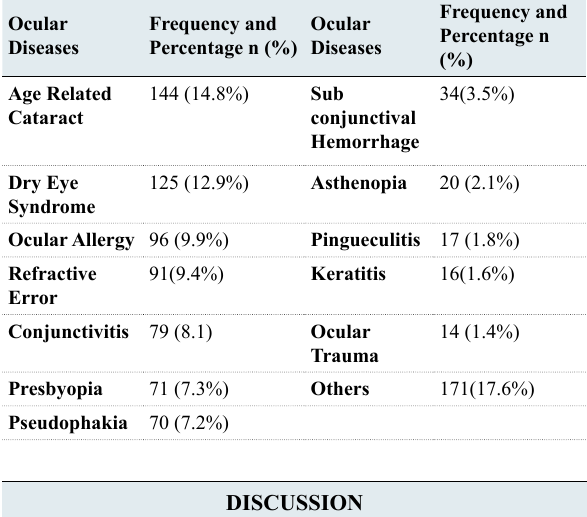
Table 1: Age and gender-wise distribution of patients attending the OPD Age Groups (in Years)